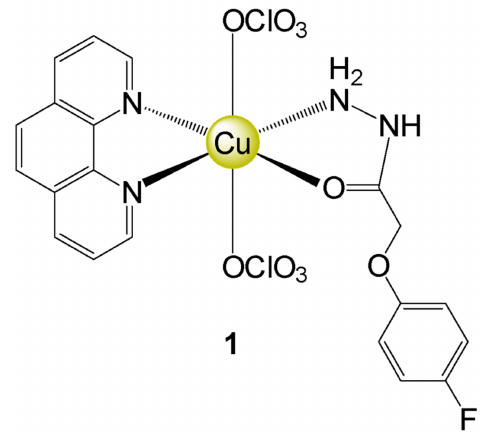
Figure 1. Structure of complex 1